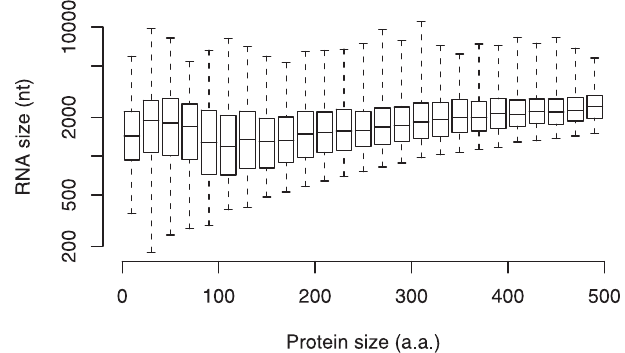
Figure 3. Box-and-Whisker Plots of RNA Sizes for Different Ranges of Protein Size The centre lines indicate the medians, the top and bottom of the boxes indicate the first and third quartiles, and the whiskers extend to the most extreme data points. DOI: 10.1371/journal.pgen.0020052.g003